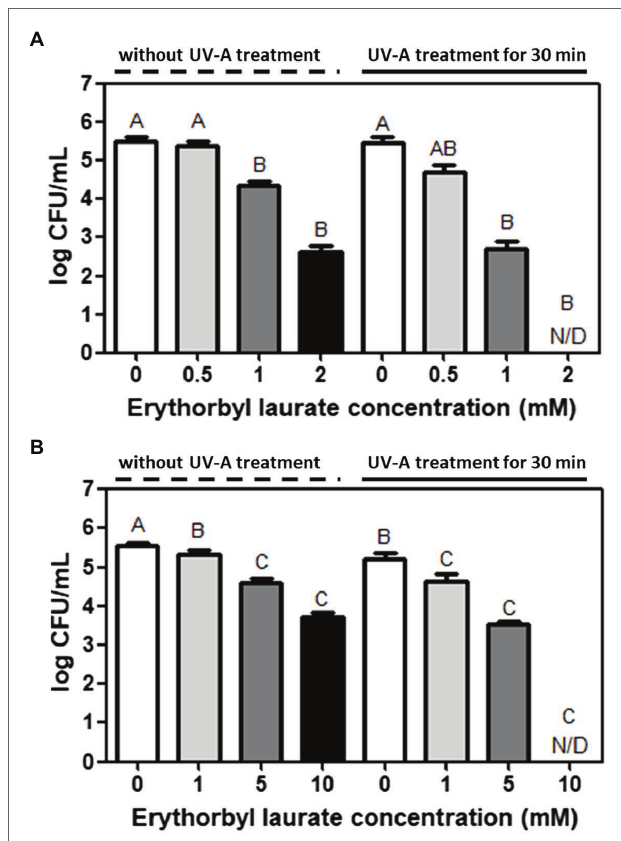
FIGURE 1 | Synergistic bacterial inactivation by erythorbyl laurate (EL) and UV Type-A (UVA) light against (A) Listeria innocua and (B) Escherichia coli O157:H7. The mean values from three independent measurements are shown. N/D, not detected. Different uppercase letters indicate significant differences ( p ≤